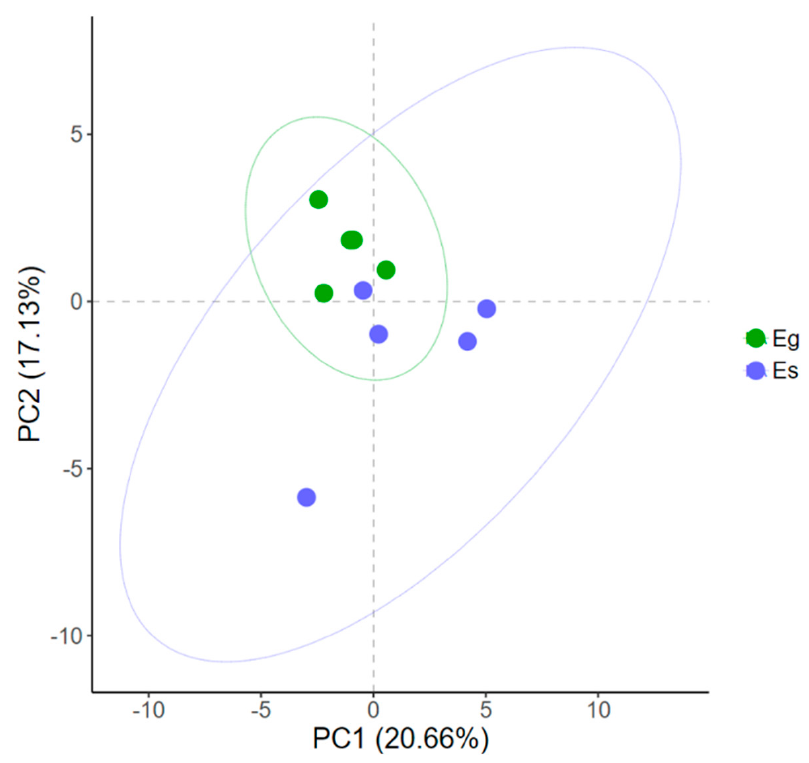
Figure 1. Principal component analysis (PCA) of the metabolic profiles of Epichloë gansuensis (Eg) and Epichloë sibirica (Es). The symbols refer to samples, and the ellipse defines the 95% confidence region.